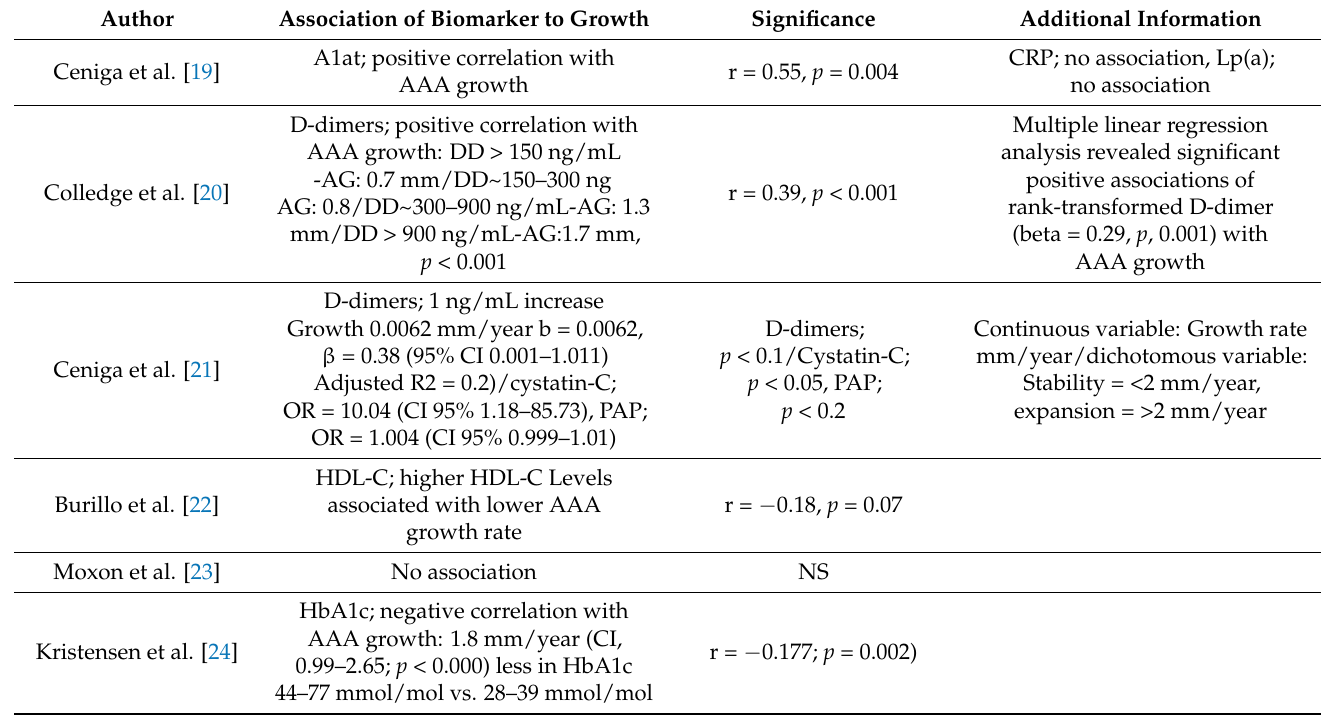
Table 5. The association between clinical biomarkers and AAA growth. Notes: AAA: Abdominal aortic